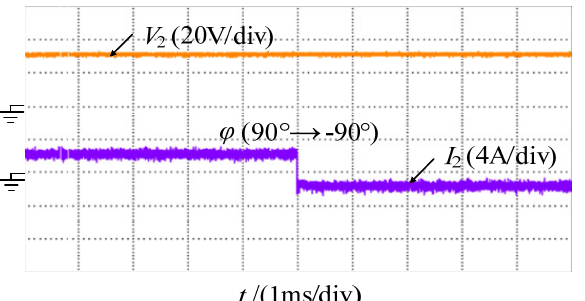
Figure 14. Measured output voltage and current waveforms when the power transmission direction is switched.